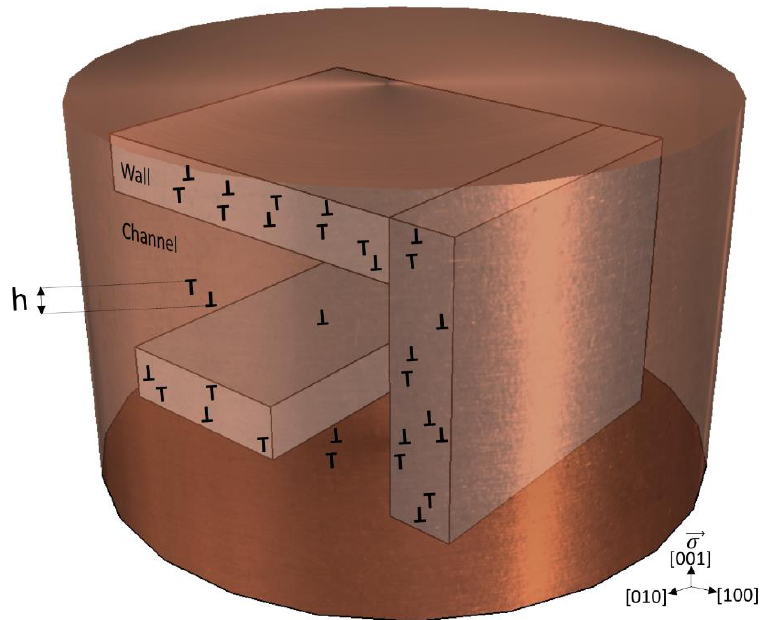
Figure 1. A three-dimensional (3-D) schematic representation of the dislocation structure illustrating the dipole height “ h ” .